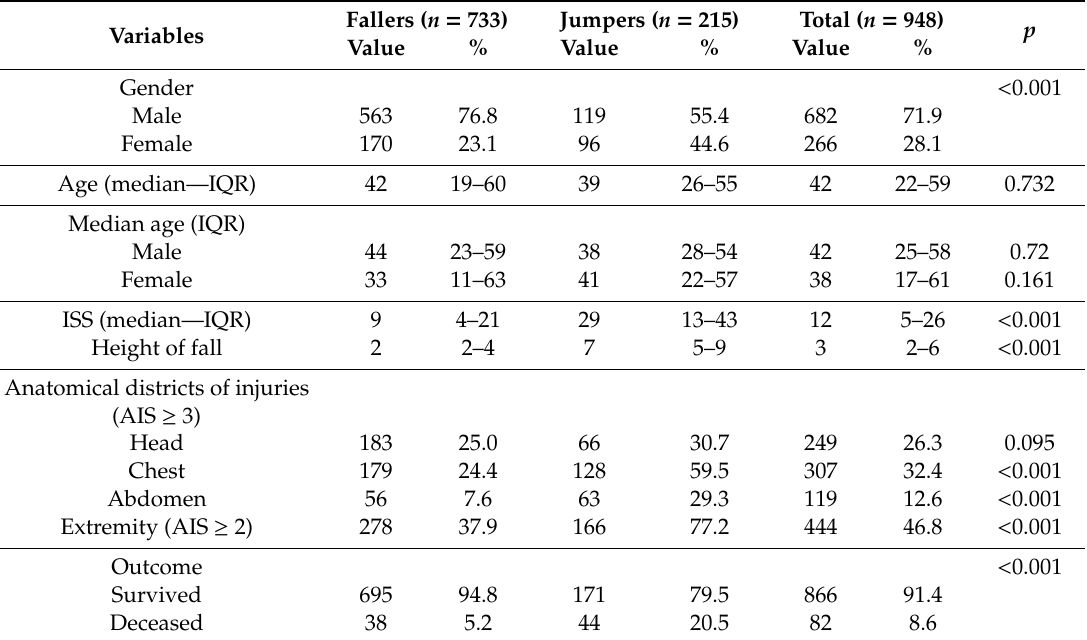
Table 1. Demographic and trauma-related data.